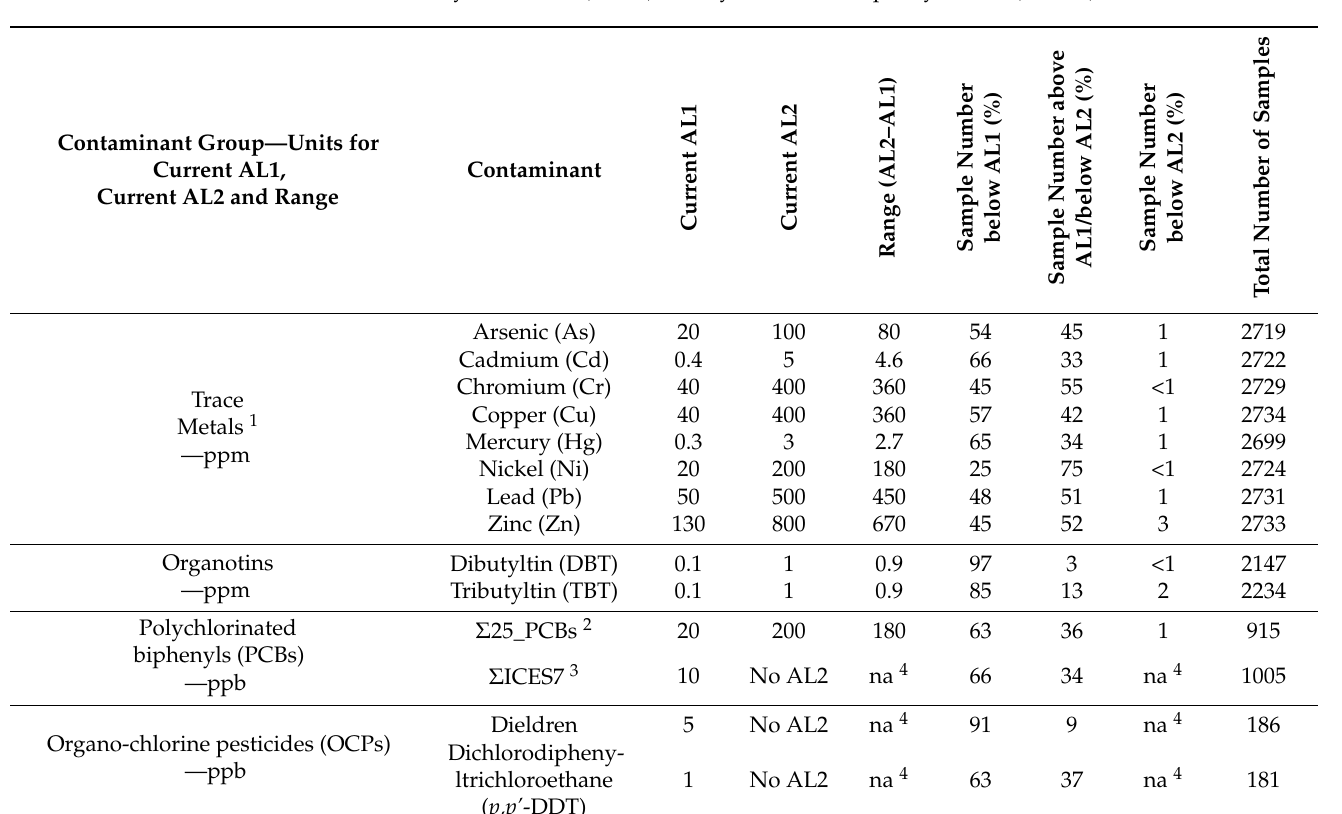
Table 5. Current Action Levels (ALs) results—Percentage of samples below AL1; between AL1 and AL2, and above AL2 and range of values between AL1 and AL2. No current ALs for Polycyclic Aromatic Hydrocarbons (PAHs) or Polybrominated diphenyl ethers